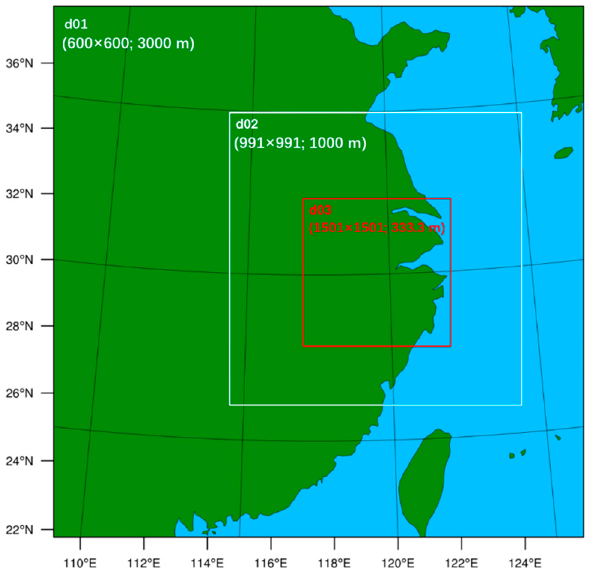
Figure 2. Three domains (d01–d03) for the simulations in this study, where the numbers in the pa- rentheses show the total grids and grid spacing for each domain.